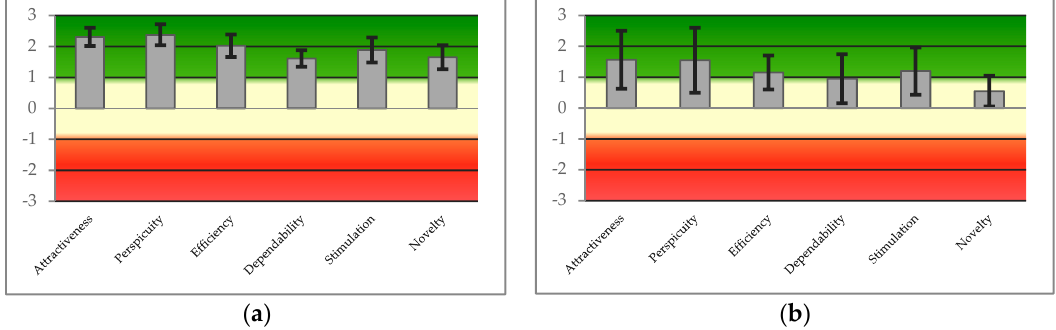
Figure 2. Graphical representation of the results for items evaluated in the UEQ questionnaire: ( a ) The results for the prototype evaluation, ( b ) the results for the Google Home application